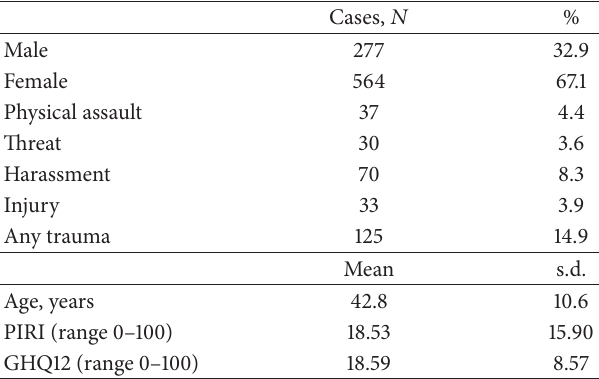
Table 1: Population and